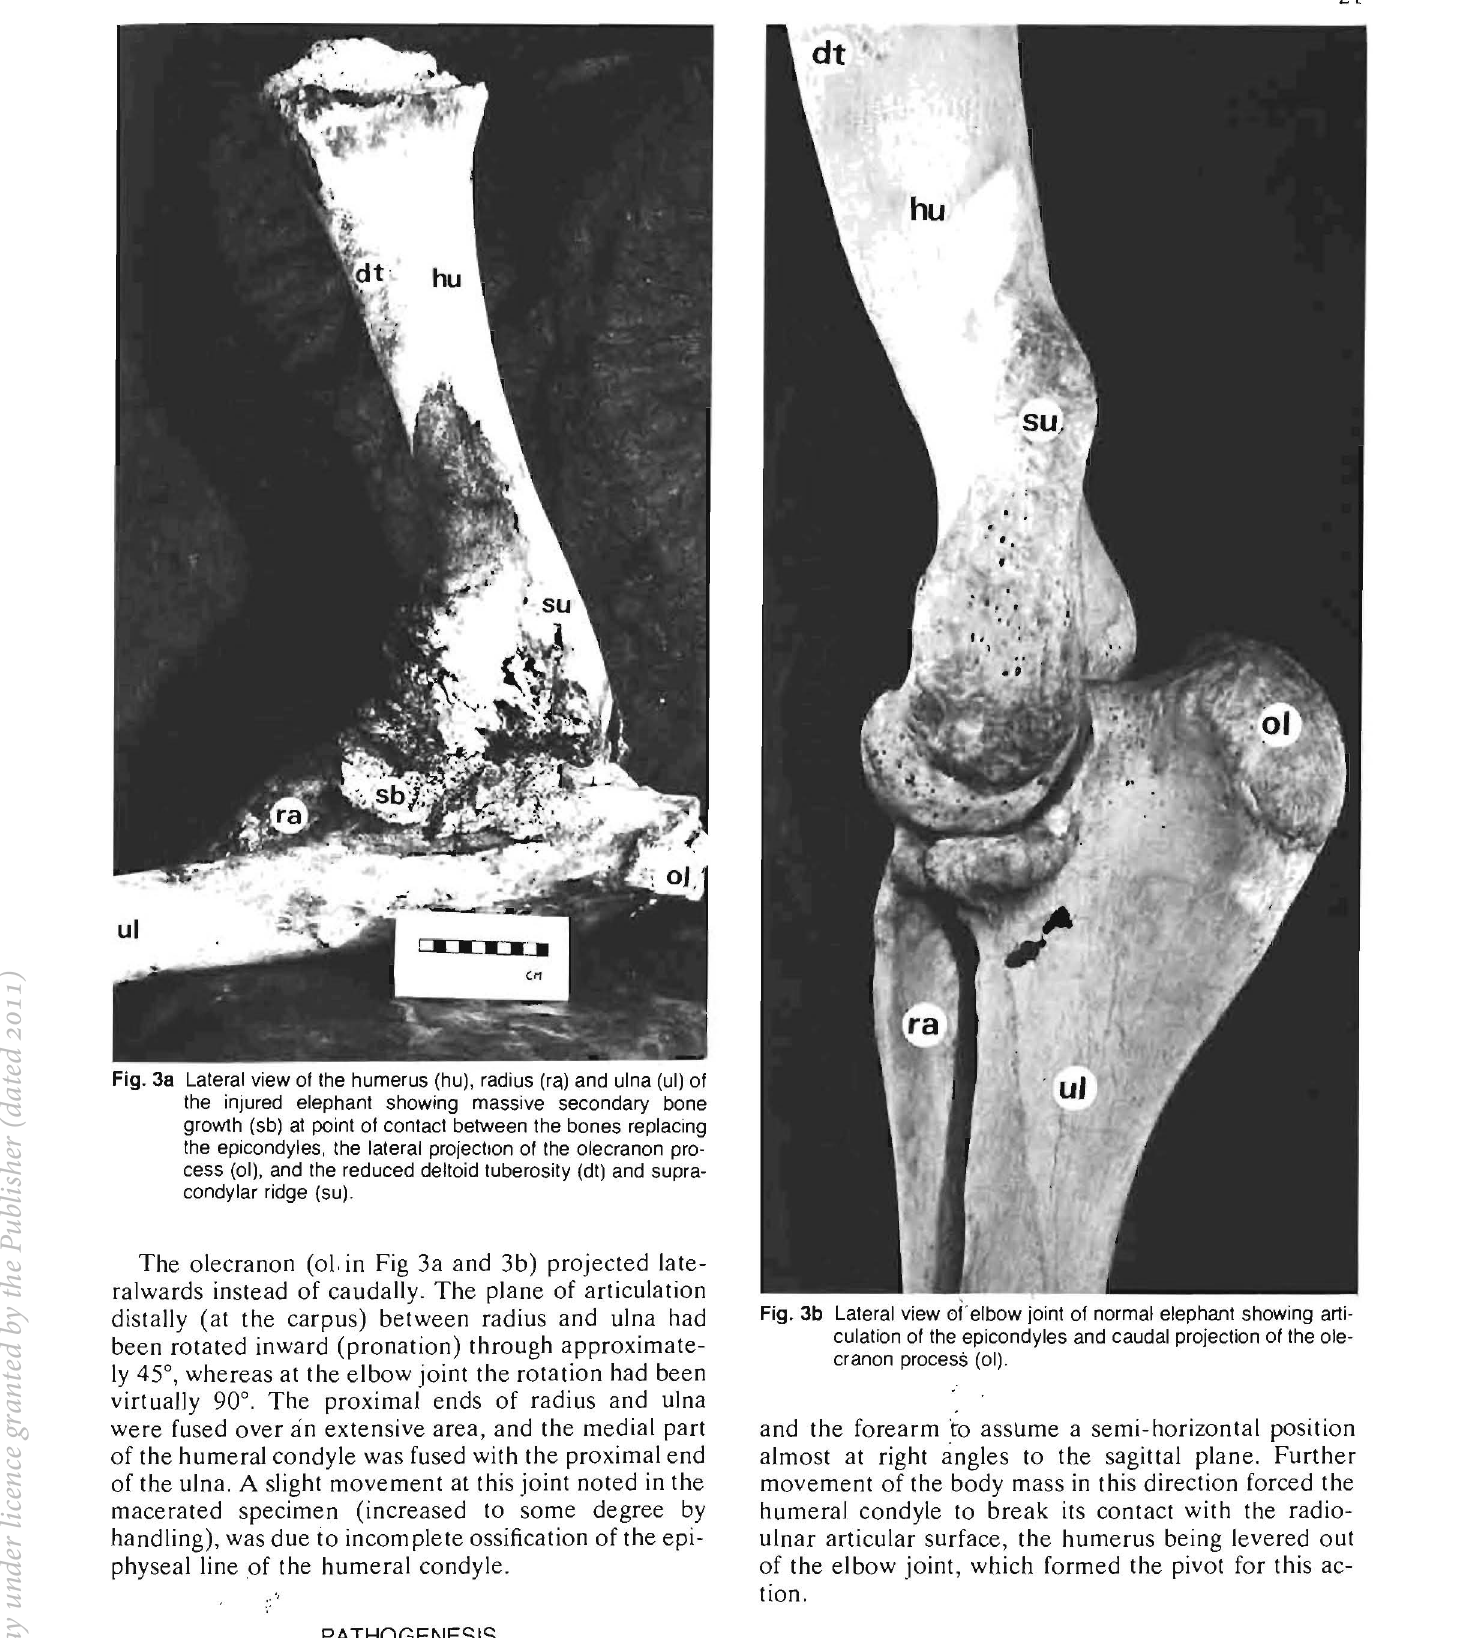
Fig. 3b Lateral view oi' elbow jOint of normal elephant showing arti culation of the epicondyles and caudal projection of the ole cranon process